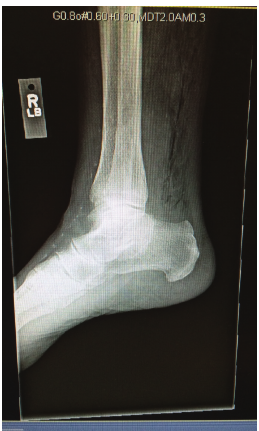
Figure 1: Radiograph of right ankle. There is diffuse subcutaneous air noted posteriorly to the